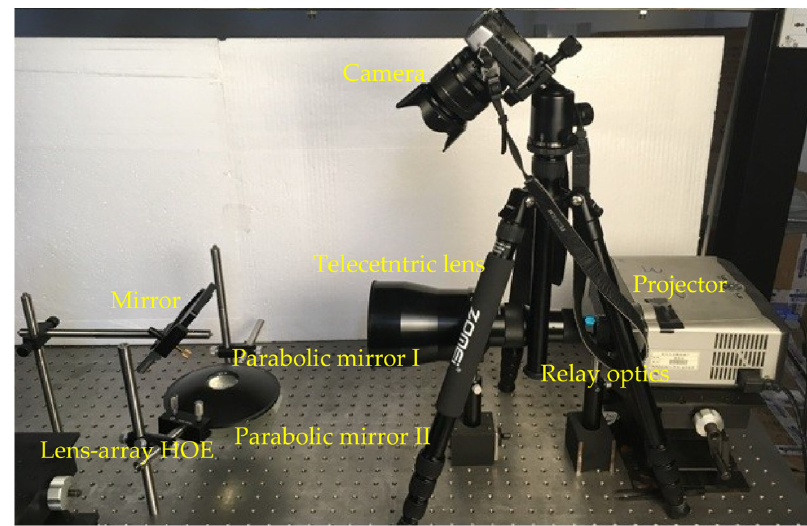
Figure 7. Experimental setup of the aerial projection 3D display based on lens-array HOE and parabolic mirrors. Table 1. Parameters of the optical devices in the experiments.